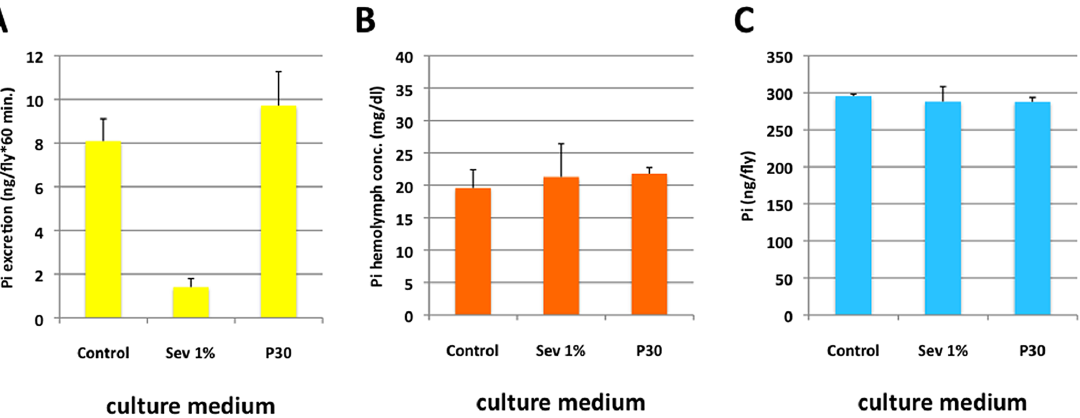
Figure 3. Adult hemolymph phosphate, phosphate excretion and whole fly Pi. A: Excretion of phosphate after culture of y w females for five days on standard medium (C) alone or supplemented with 1% sevelamer (Sev1%) and 30 mM sodium phosphate (P30) (n=3 pooled collections of 15–20 flies). B: hemolymph phosphate concentration (n=3 pooled collections of 15 flies) and C: whole fly phosphate (n=10) of flies cultured as described for A. Note that y w and CS flies have lower hemolymph phosphate concentrations than OR and w 1118 flies and the F1 generation females that express control RNAis (see Methods and Fig. S5), which is likely due to differences in genetic background.